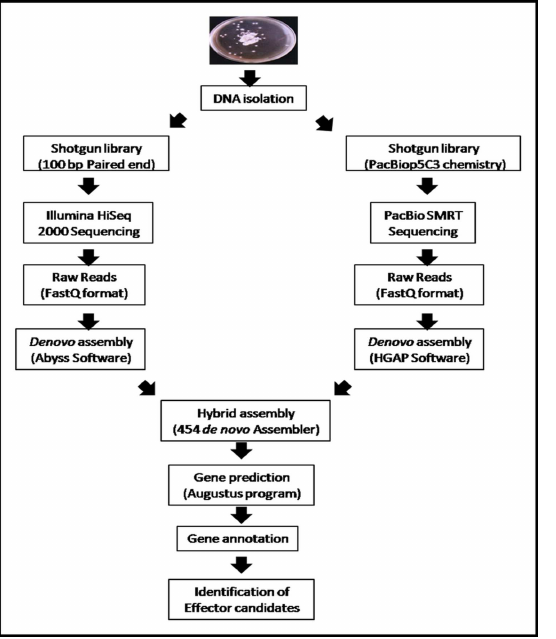
Fig 1. Overall workflow for de novo genome sequencing, assembly and annotation of T . indica Karnal isolate for identification of Effector Candidates.